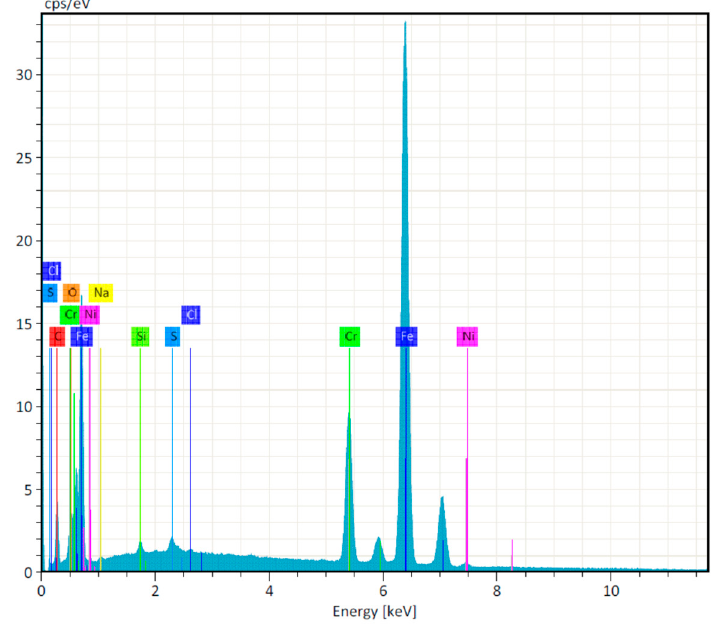
Figure 6. Group 3. T he spectroscopic analysis of the drill surface after 50 steam autoclave cycles, where no changes in iron, nickel, and chromium levels and a smaller increase in oxygen